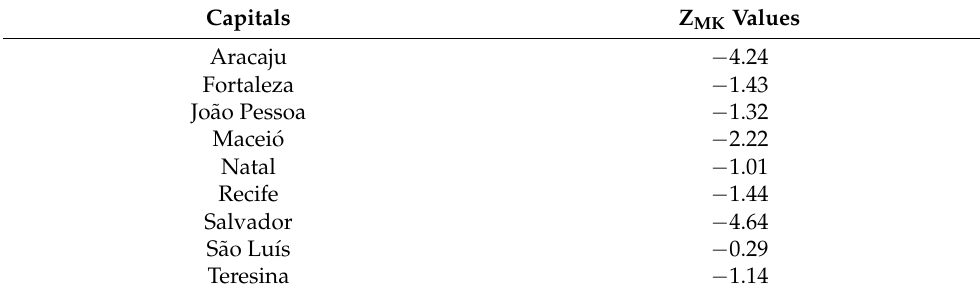
Table 6. Rainfall trend via MK test applied to Northeast